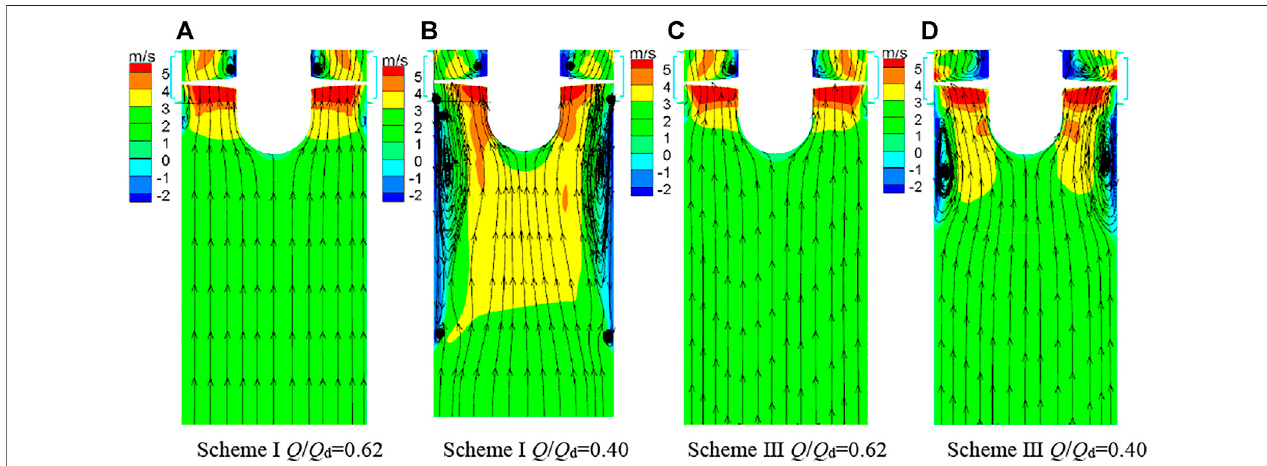
FIGURE8| Internal fl owcharacteristicsoftheinletpipeandimpellerofthefull-tubularpump. (A) Scheme Ⅰ Q/Qd=0.62, (B) Scheme Ⅰ Q/Qd=0.40, (C) Scheme Ⅰ IIQ/ Qd=0.62, (D) Scheme Ⅰ II Q/Qd=0.40.